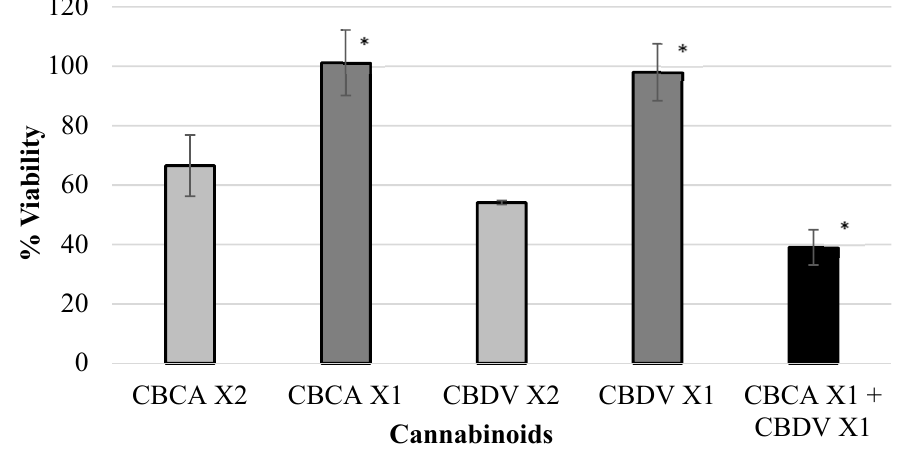
Figure 2. Viability of polyp cells exposed to CBDV and CBCA. Combinations between CBCA (at X2 concentration—29 µM or X1 concentration—14.5 µM) and CBDV (at X2 concentration—47 µM or X1 concentration—23.5 µM) significantly inhibited the viability of polyp-derived cells. The canna-